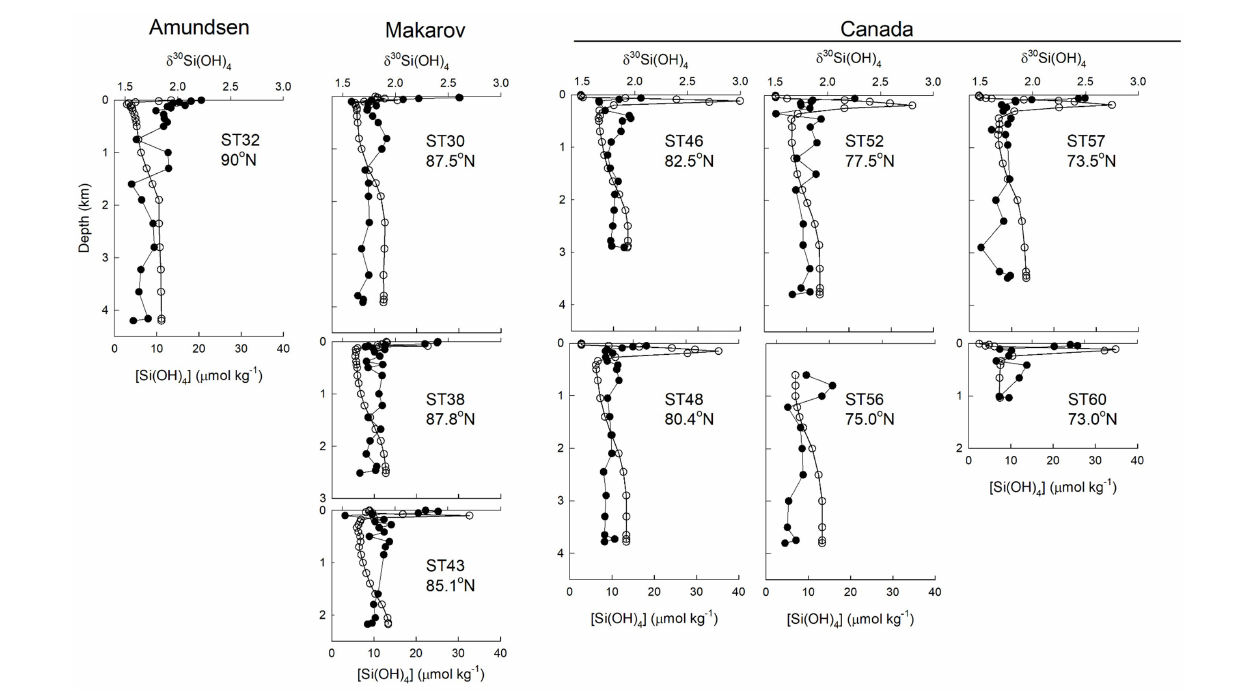
FIGURE 6 | Profiles of silicic acid concentration (open circles) and δ 30 Si(OH) 4 (filled circles) for stations in the Canada Basin (stations 46, 48, 52, 56, and 57), Makarov Basin (stations 30, 38), and Amundsen Basin (Station 32).